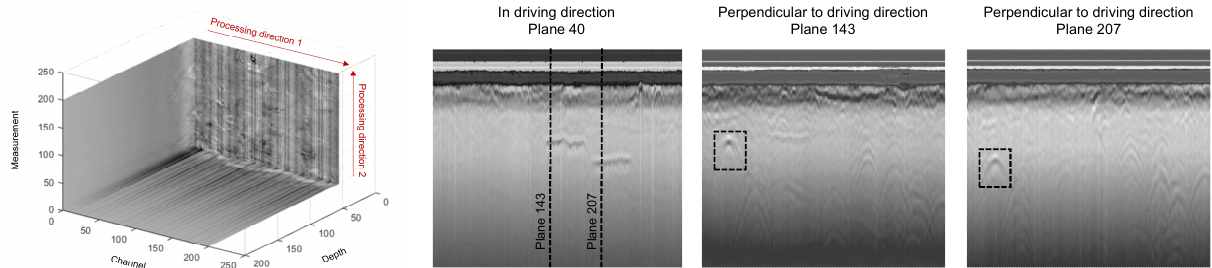
Figure 7 . Processing directions of the data Figure 8 . Results of pre-processing. The image on the left shows the 40 th plane in cube. driving direction. The image in the middle shows the plane 143, the right image the result of plane 207 perpendicular to driving direction.